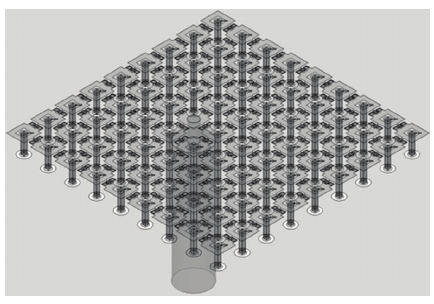
Figure 3: Frequency reconfigurable pixel patch antenna [6].